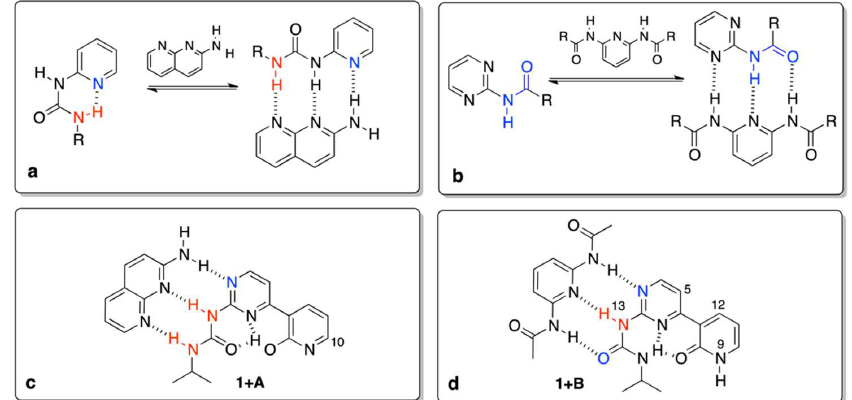
Figure 3. The previously ( a , b ) and currently ( c , d ) studied complexes.